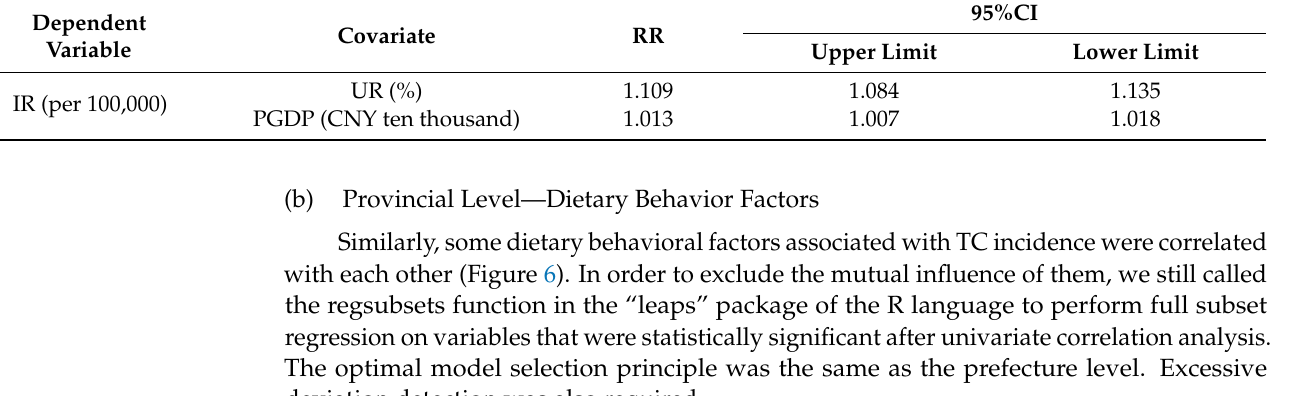
Figure 7. R 2 ( left ) and BIC ( right ) values for models with different dietary behavioral factors. The higher the aquatic product consumption per capita, the higher the incidence of TC (RR = 1.047, 95%CI: 1.020 to 1.075). That was, for every 1kg increase in aquatic prod-